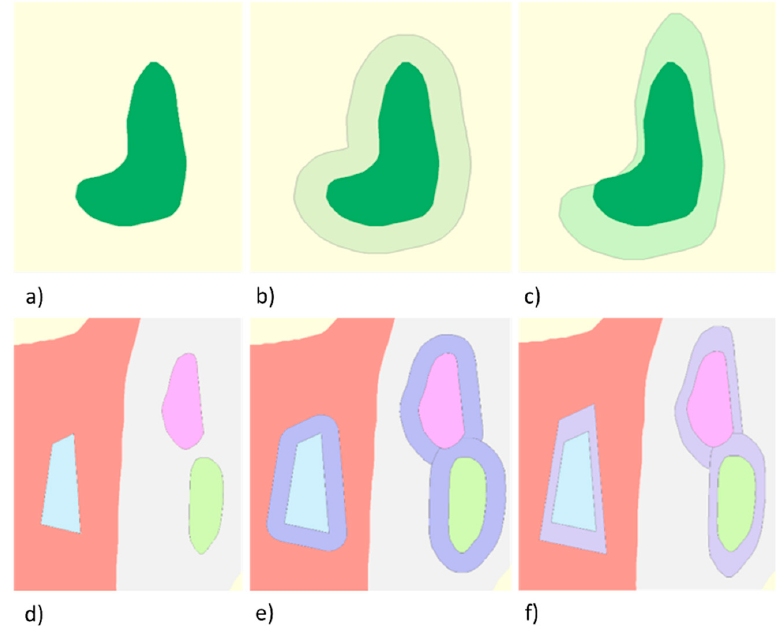
Figure 5. Enlargement. ( a , d ) The original polygons. ( b , e ) Those enlarged by the buffering algorithm. ( c , f ) Those enlarged by the scaling algorithm.